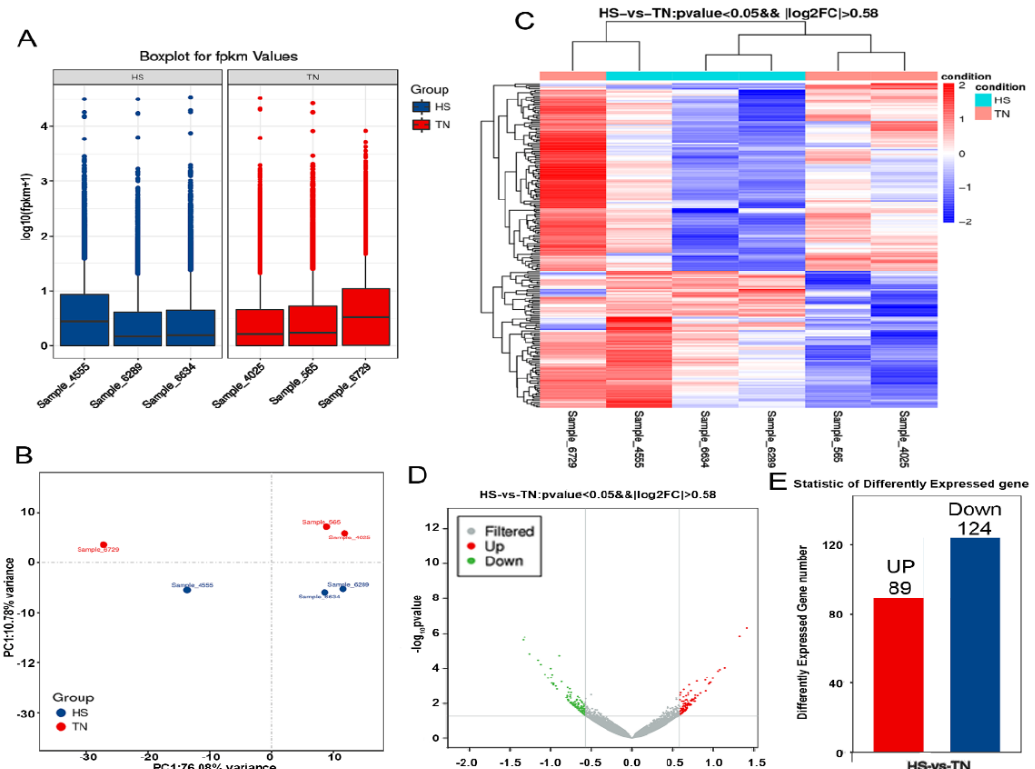
Figure 2. Effect of HS on transcriptomes in mammary gland tissues. ( A ) The distribution of FPKM (fragments per kb per million reads) values in HS and TN groups. ( B ) Principal component analysis was utilized to determine the reliability of the data, simplify the complexity of RNA-seq, and reduce the effective dimension of gene expression space. Heatmap ( C ) and volcano map ( D ) show the differentially expressed genes between HS and TN groups. ( E ) A total of 213 differentially expressed genes (DEGs) were identified, among which 89 were upregulated, and 124 downregulated between the groups studied.